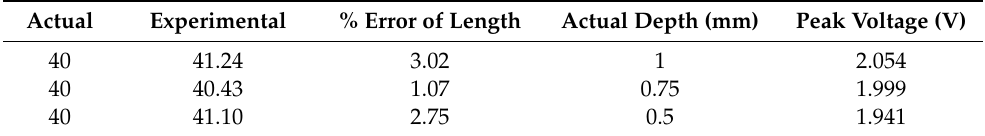
Figure 13. De-noised distance sensor signal for cavity corrosion defects scanned at 2.9 mm/s and 20-mm lift-off. Table 6. Percentage error of cavitation corrosion defects for 20-mm lift-o ff and inspection speed at 2.8 mm /